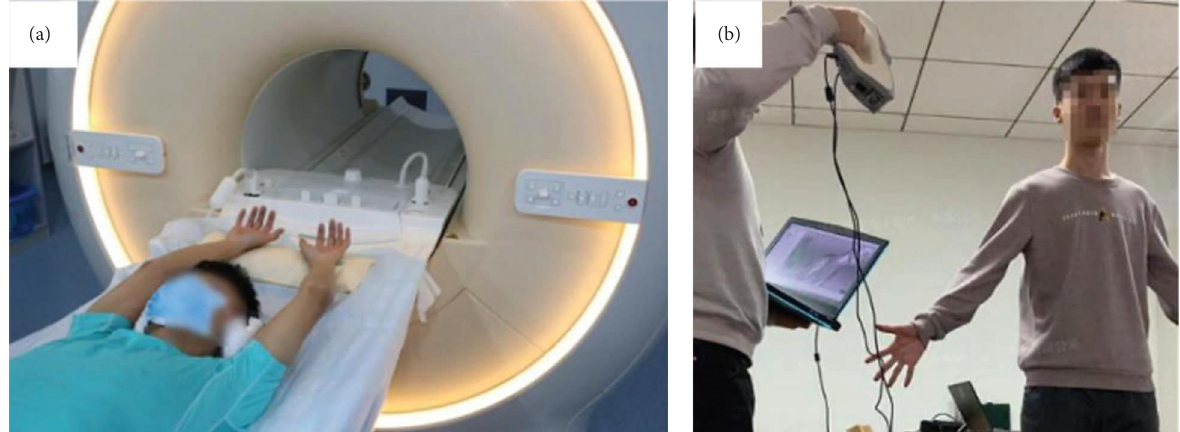
Figure 19: CT scan (a) and 3D scan (b).